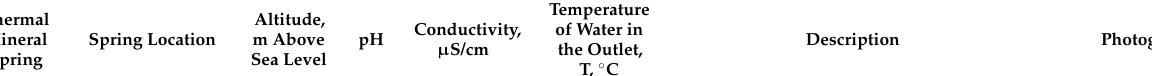
Table 1. General characteristics of Armenian and Nagorno-Karabakhian geothermal springs.